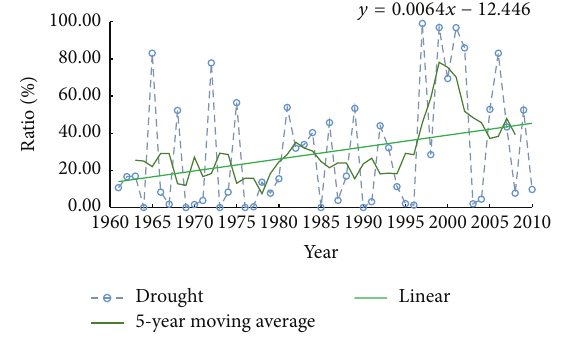
Figure 4: The interannual variability of drought area.